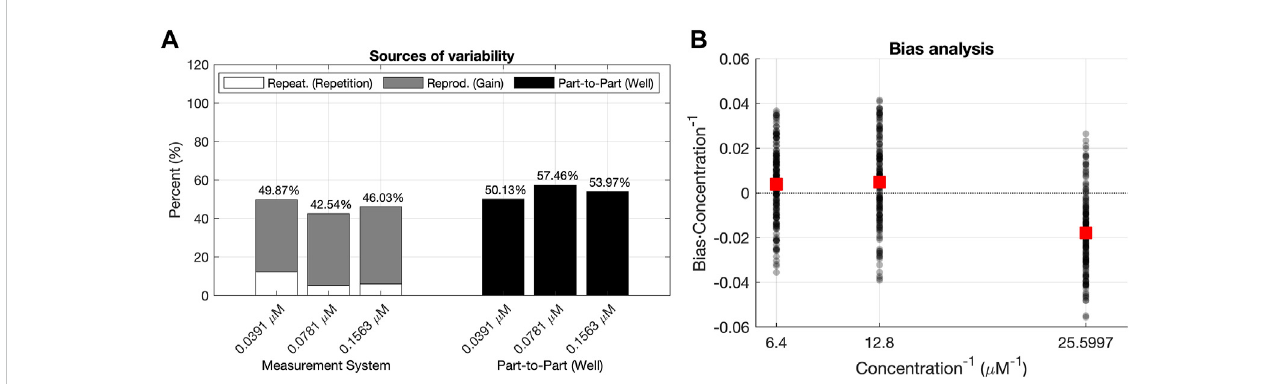
FIGURE 5 Analyses of the validation data set. (A) R&R analysis for the validation dataset. The total variability is decomposed into the Part – to – Part ( σ 2 P 2 P ) and the Measurement System contribution. In turn, the Measurement System contribution contains both Repeatability plus Reproducibility values. The Part-to-Part variability represents the differences between ^ C values for different wells with the same fl uorescein concentration. The Reproducibility (Gain) variability ( σ 2 ) represents the differences between concentration values for the same measurement recorded at different gain levels. (B) L&B analysis for the Reprod validation data set, illustrating the scattering of the scaled bias values (black dots) for each Concentration − 1 level. The plot illustrates also if there is a tendency between average values of the scaled bias (red squares) and the Concentration − 1 .